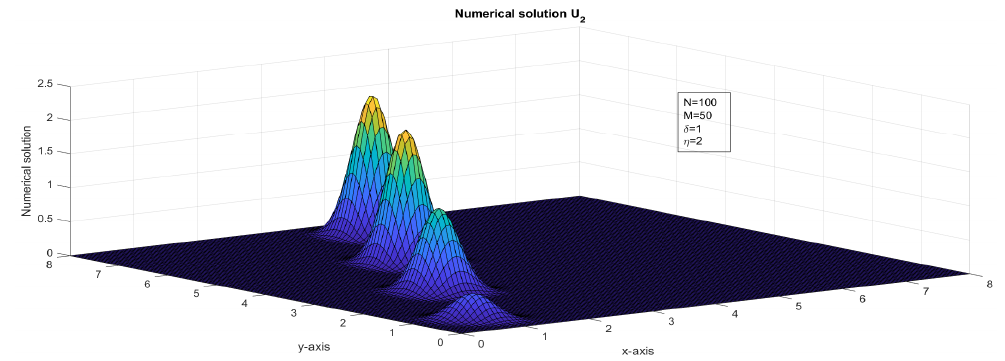
Figure 16. The surface plot illustrates the numerical solution, U 2 , for Case 3 in Example